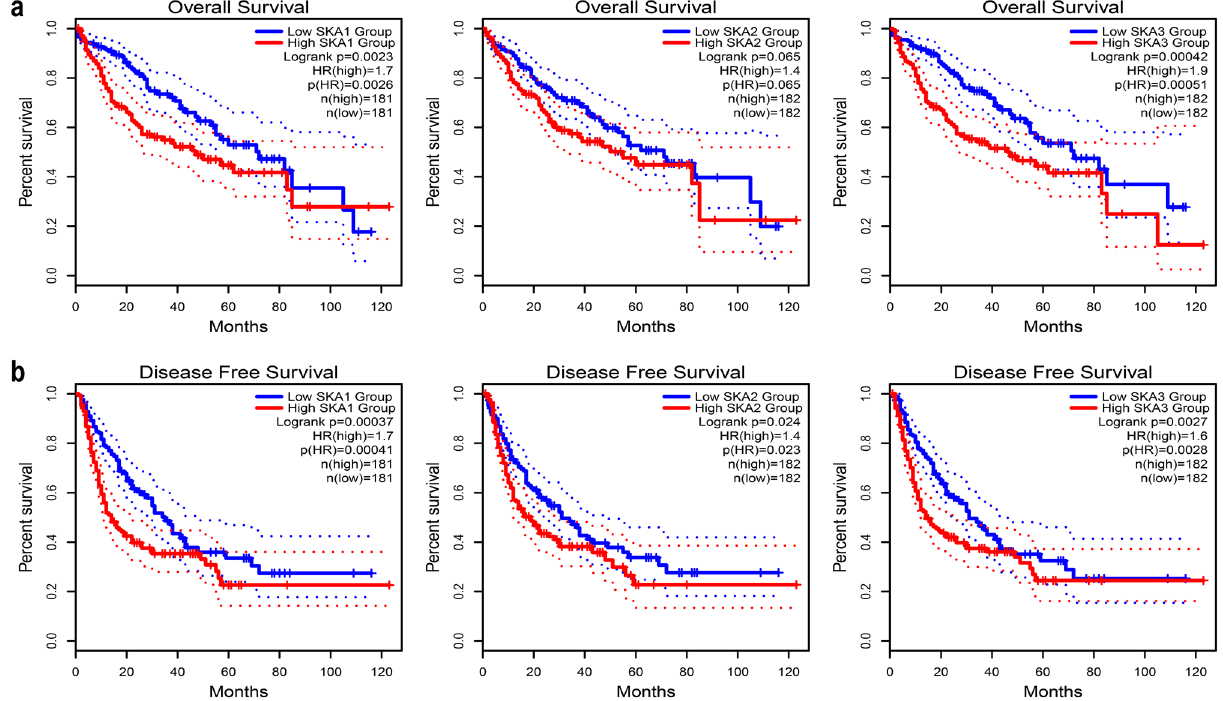
Figure 4. The prognostic value of mRNA expression level of SKAs in HCC patients (GEPIA2). ( a ) The relationship between SKAs expression and OS in HCC patients. ( b ) The relationship between SKAs expression and DFS in HCC patients. OS overall survival; DFS disease-free survival.